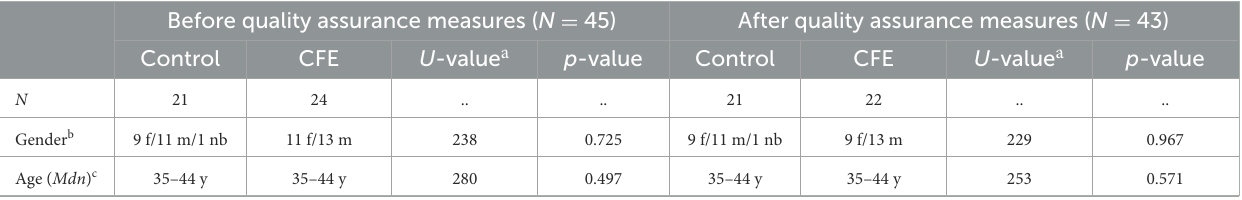
TABLE 2 Demographic information of participants in Experiment 2.